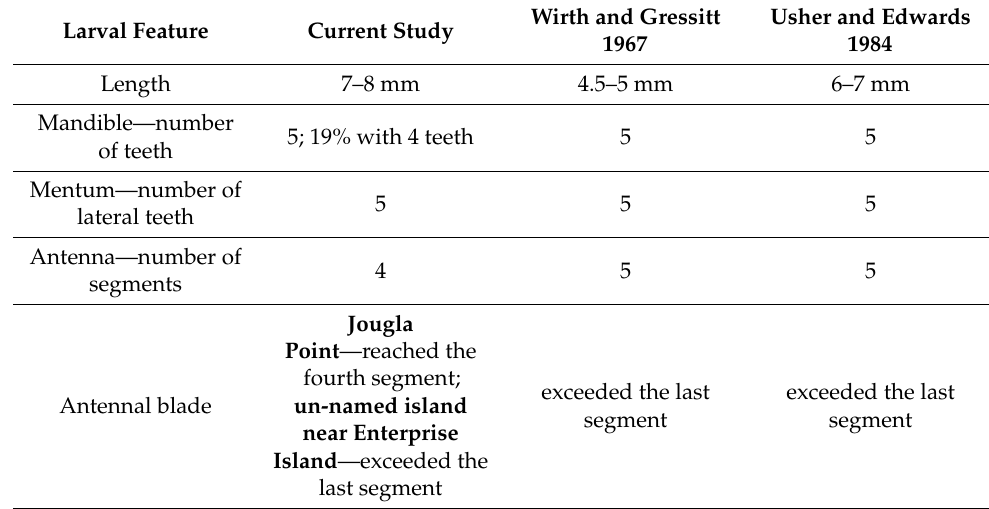
Table 3. Comparative analysis of morphological features of larvae of Belgica antarctica assessed in the current study and previously reported by Wirth and Gressitt (1967) [14] and Usher and Edwards (1984) [13]. Larval